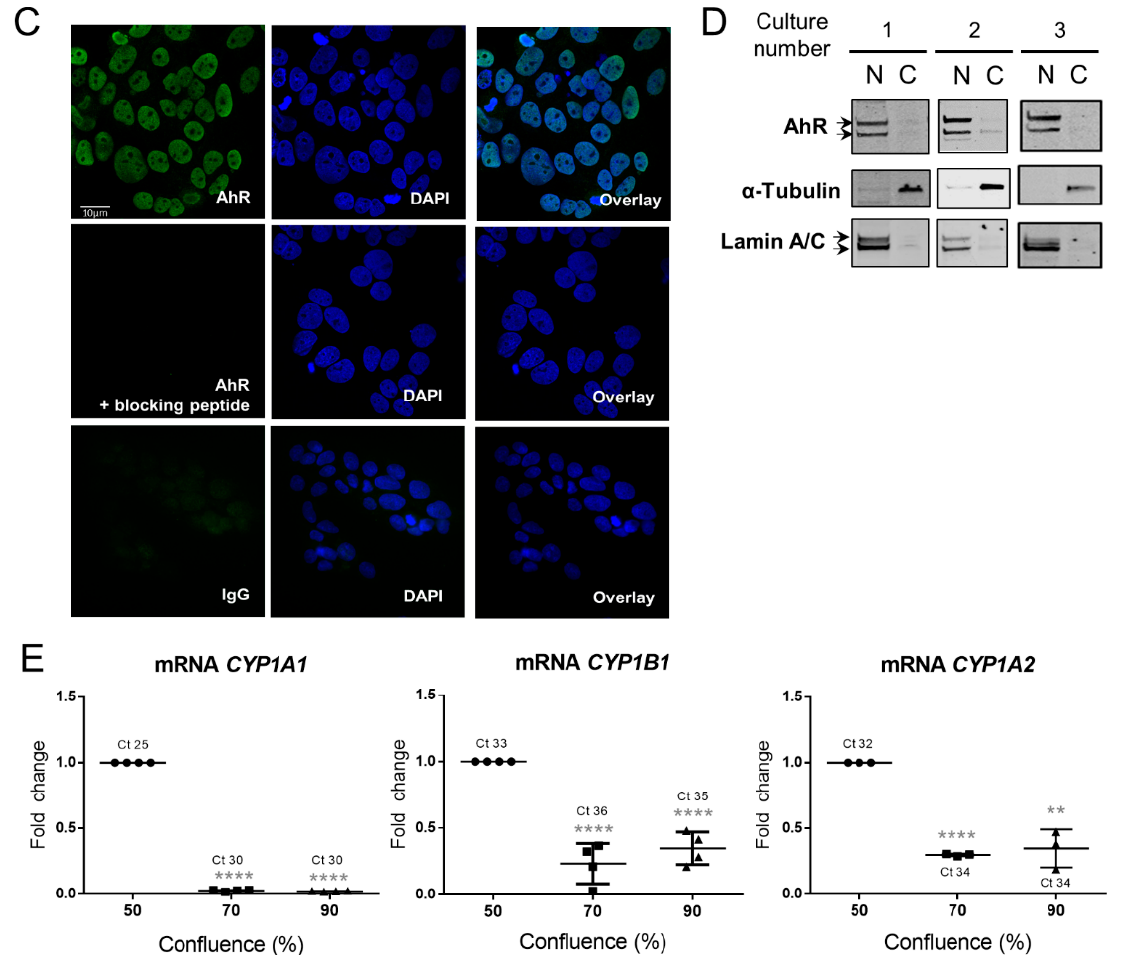
Figure 5. AhR expression, localization, and activity in the BeWo cell line. ( A ) Total mRNA were extracted from BeWo cells at various cell densities: 24 h hours after seeding cells reach about 50% of confluence; 48 h after seeding, they reached about 70% confluence, and about 90% 72 h after seeding. Levels of AhR, AhRR, and ARNT were determined by RT-qPCR and normalized to the geometric mean of HPRT , RPL13 , and Ubiquitin C transcripts. The means (long horizontal lines) and standard deviations (short horizontal lines) of four independent experiments are shown. ** compared to 50% confluence p < 0.01; ## compared to 70% p < 0.001; **** compared to 50% confluence p < 0.0001. Ct is the raw value of gene without normalization to reference genes ( B ) Total proteins were analyzed by immunoblotting using AhR antibody alone or pre-incubated with its blocking peptide, using ARNT and β -Actin antibodies, used as a loading control (left panel). The graph represents the amount of total AhR protein relative to β -Actin level determined by quantification of the immunoblot using the Odyssey System Imager (right panel). The means (long horizontal lines) and standard deviations (short horizontal lines) of three independent experiments are shown. ( C ) BeWo cells were fixed in 4% PFA and permeabilized with 0.1% Triton. Images are of epifluorescence microscopy after staining of AhR alone (green, upper images), AhR pre-incubated with a blocking peptide (middle images), or IgG (lower images) and DAPI (blue, for nuclei). The overlay images are shown at right. Images are relative to five independent experiments. ( D ) Immunoblotting was carried out using anti-AhR antibody after cell fractionation of BeWo cells to separate the nuclear and cytosolic extracts. α -Tubulin and Lamin A/C are nuclear and cytosolic markers, respectively. N: Nucleus, C: Cytosol. ( E ) Levels of CYP1A1 , CYP1B1 , and CYP1A2 were determined and normalized to the geometric mean of HPRT , RPL13 , and Ubiquitin C transcripts. The means (long horizontal lines) and standard deviations (short horizontal lines) of at least three independent experiments are shown. ** compared to 50% confluence p < 0.01; **** compared to 50% confluence p < 0.0001. Ct is the raw value of interest gene without normalization to reference genes.